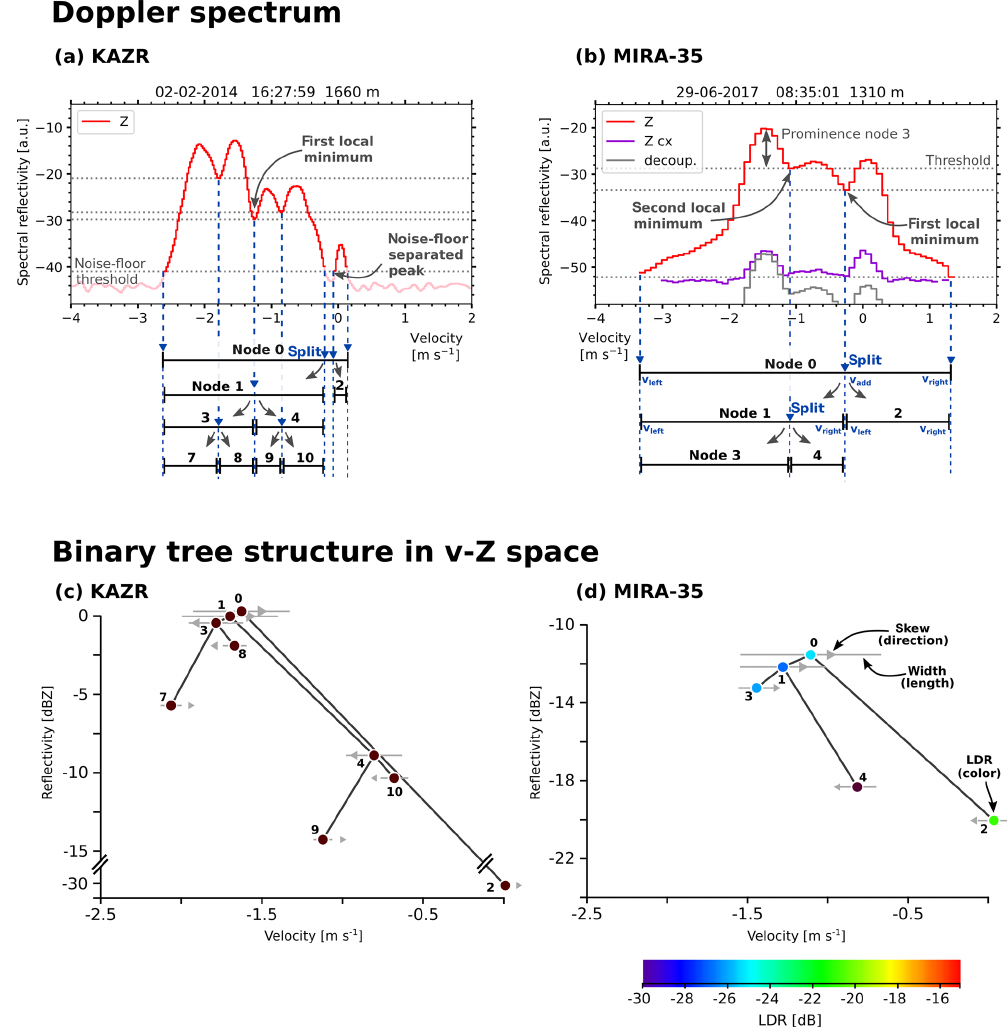
Figure 2. Example for generating the trees for two Doppler spectra from different cloud radars of type KAZR (a, c) and MIRA-35 (b, d) . The root node (node 0) is split into child nodes at the indicated velocity bins (dashed blue), which contain a local minimum in spectral reflectivity. The threshold defined by the noise floor and the internal minima is marked with dashed grey lines. In the spectrum in (b) the reflectivity in the cross-polarized channel ( Z cx) is shown together with the co-polarized channel signal subtracted by the polarization decoupling (further explanation in Sect. 2.1). Panels (c) and (d) show the resulting trees, for which the location of a node in the v − Z space is based on its moments. Spectral width is indicated quantitatively by the length of the grey lines, and the sign of the skewness is indicated by a triangle (pointing left for negative skewness and vice versa). The circle denoting the node position is color-coded in accordance with the node LDR. Table 2. Moments for each peak from the MIRA-35 Doppler spectrum depicted in Fig. 2b with the index of the node according to the level-order tree traversal and the boundaries v left and v right in ms − 1 . Child nodes are denoted by their level of indentation. The units are dBZ for reflectivity Z and ms − 1 for v and spectral width σ . The skewness γ is dimensionless; LDR is in dB. The threshold “Thres.” is in dBZ and the prominence “Prom.” is in